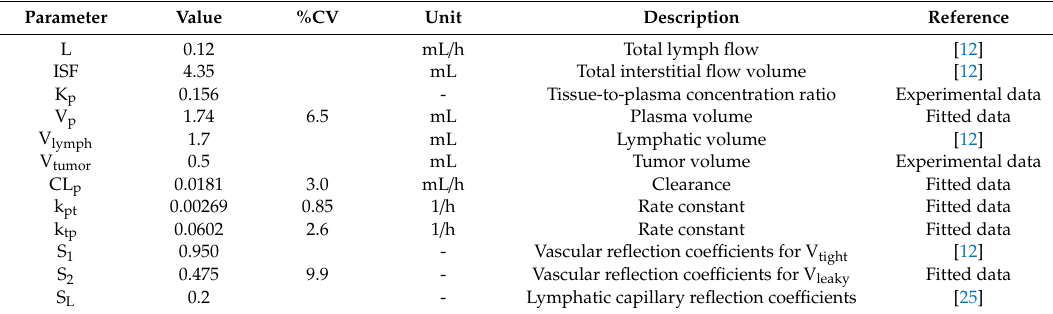
Table 3. The pharmacokinetic parameters used in the minimal PBPK model in